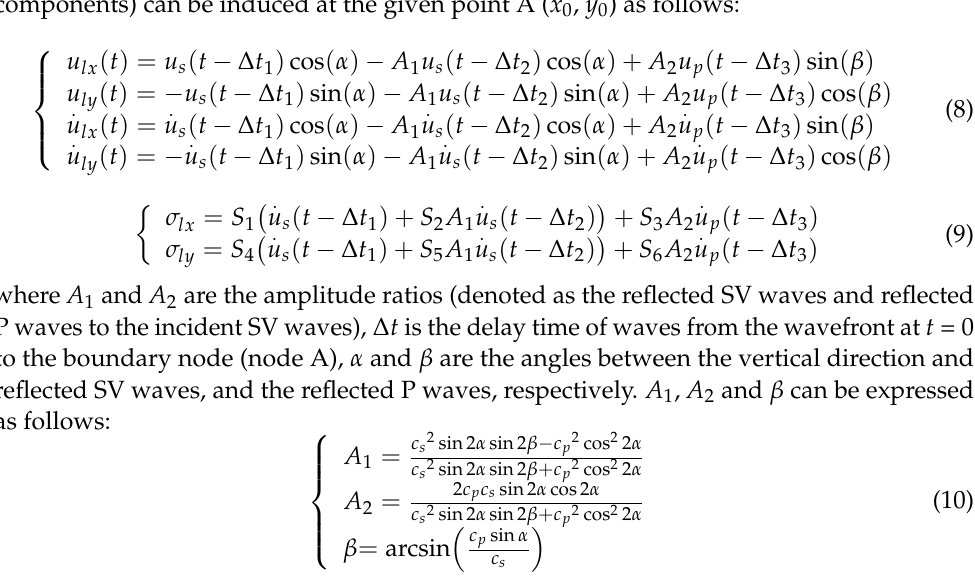
Figure 3. Sketch of the seismic waves on truncated boundary by obliquely incident SV waves. Consequently, the free-field motion and the associated stress (in terms of x and y components) can be induced at the given point A ( x 0 , y 0 ) as follows: